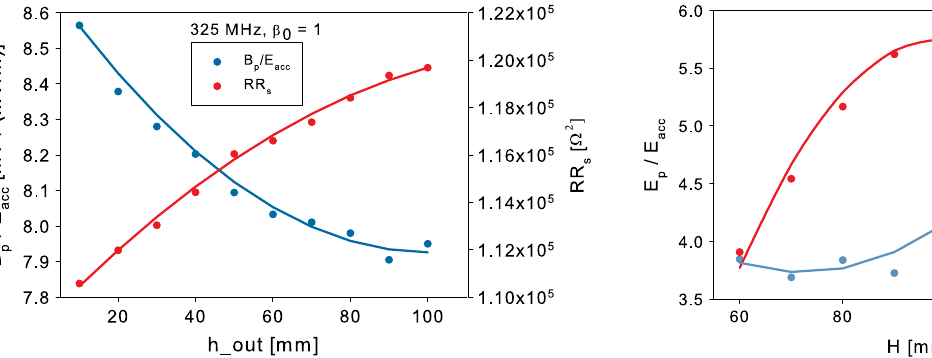
FIG. 27. Dependence of the normalized magnetic field and RR s on the parameter h_out.